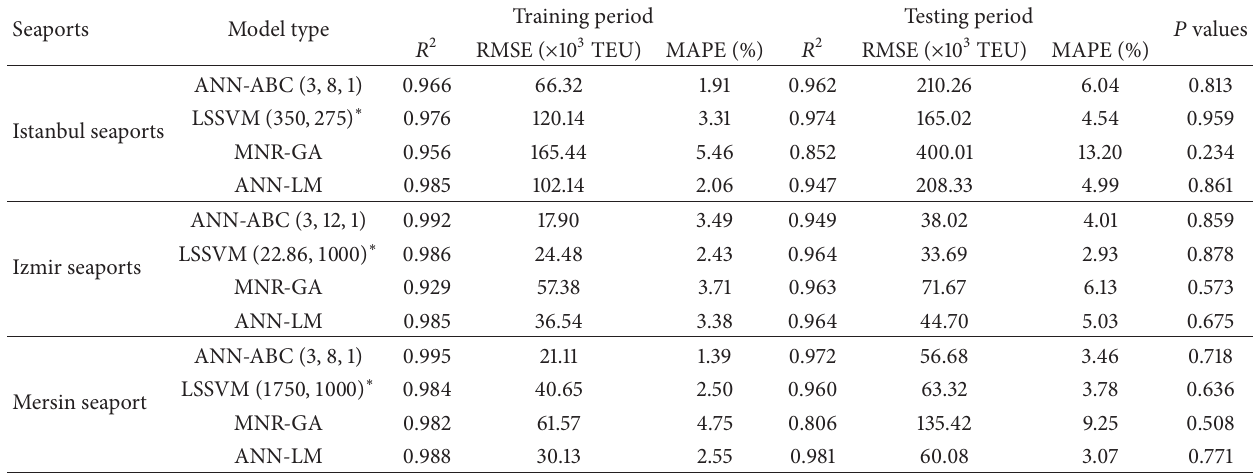
Table 3: Performances of the best performing models of each seaport.